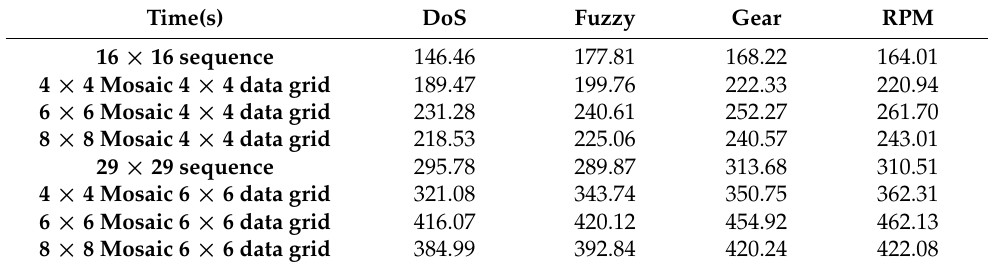
Table 5. Program running